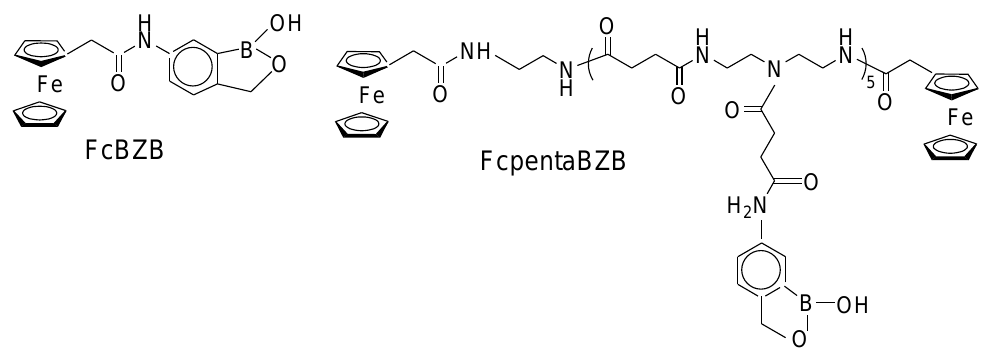
Figure 10. Chemical structures of ferrocene-modified